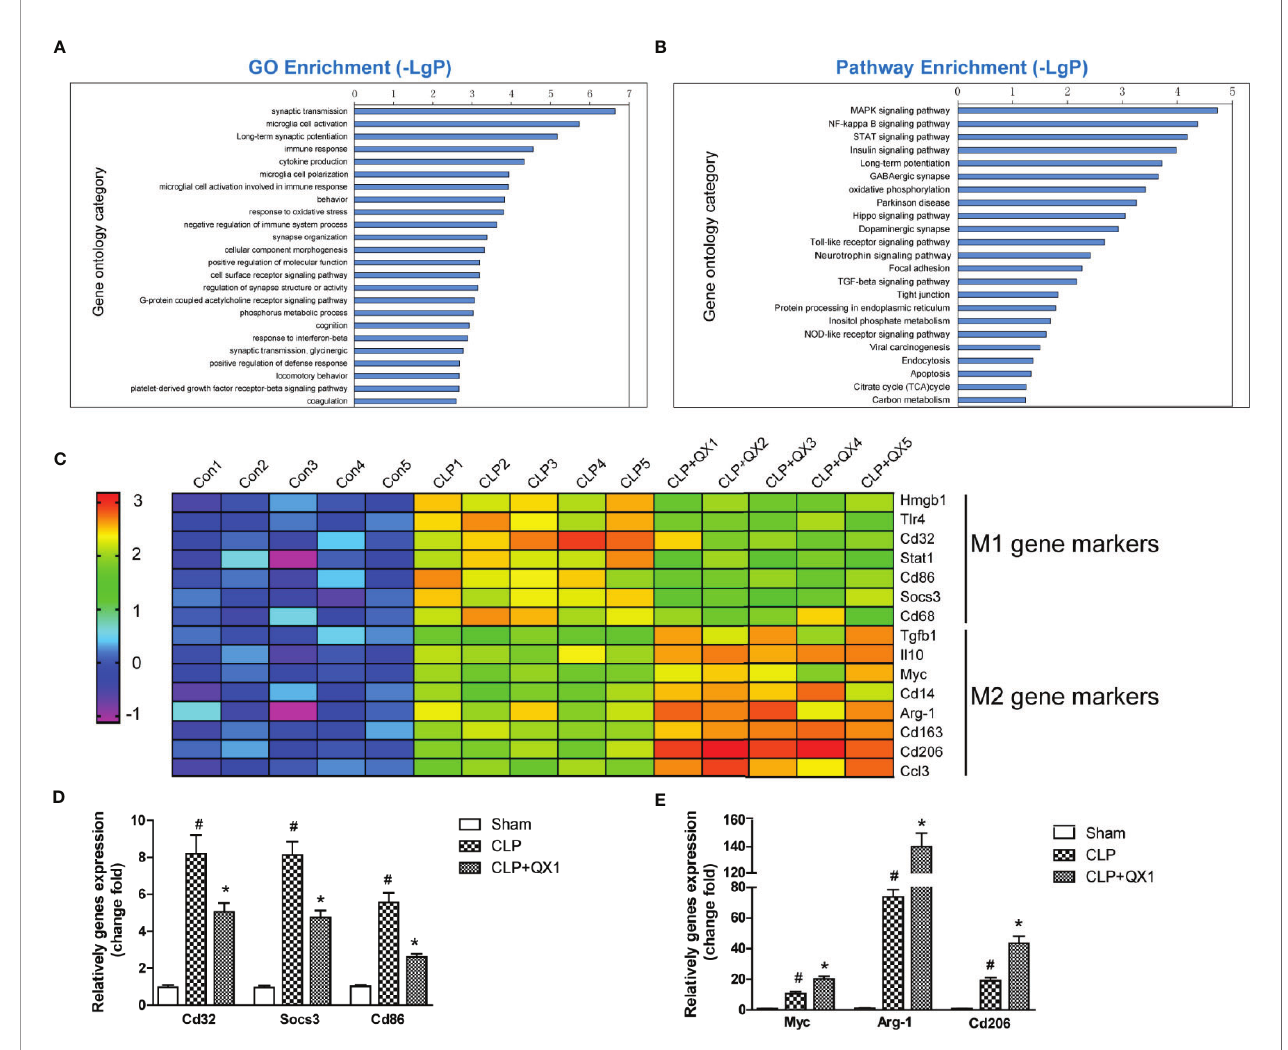
FIGURE 7 | QX1 formula promotes microglia polarization in septic mice. Transcriptional pro fi ling and bioinformatics analysis of the hippocampus in septic mice at day 10 after surgery (n=5 per group). (A) GO analysis and (B) KEGG pathway enrichment analysis of differential genes. -LgP is the logarithm of p value. (C) Expression of microglia M1 and M2 polarization related genes in log 2 value in transcriptional pro fi ling. Realtime-PCR validation of (D) M1 and (E) M2 microglia polarization related genes identi fi ed from the microarray analysis upon CLP and CLP+QX1 formula treatment (n=12 per group). Data were shown as mean ± SD. # p < 0.05 vs. sham, * p < 0.05 vs. CLP, one-way ANOVA. GO, Gene Ontology; KEGG, Kyoto Encyclopedia of Genes and Genomes; CLP, Cecal Ligation and Puncture; QX1, Qiang Xin